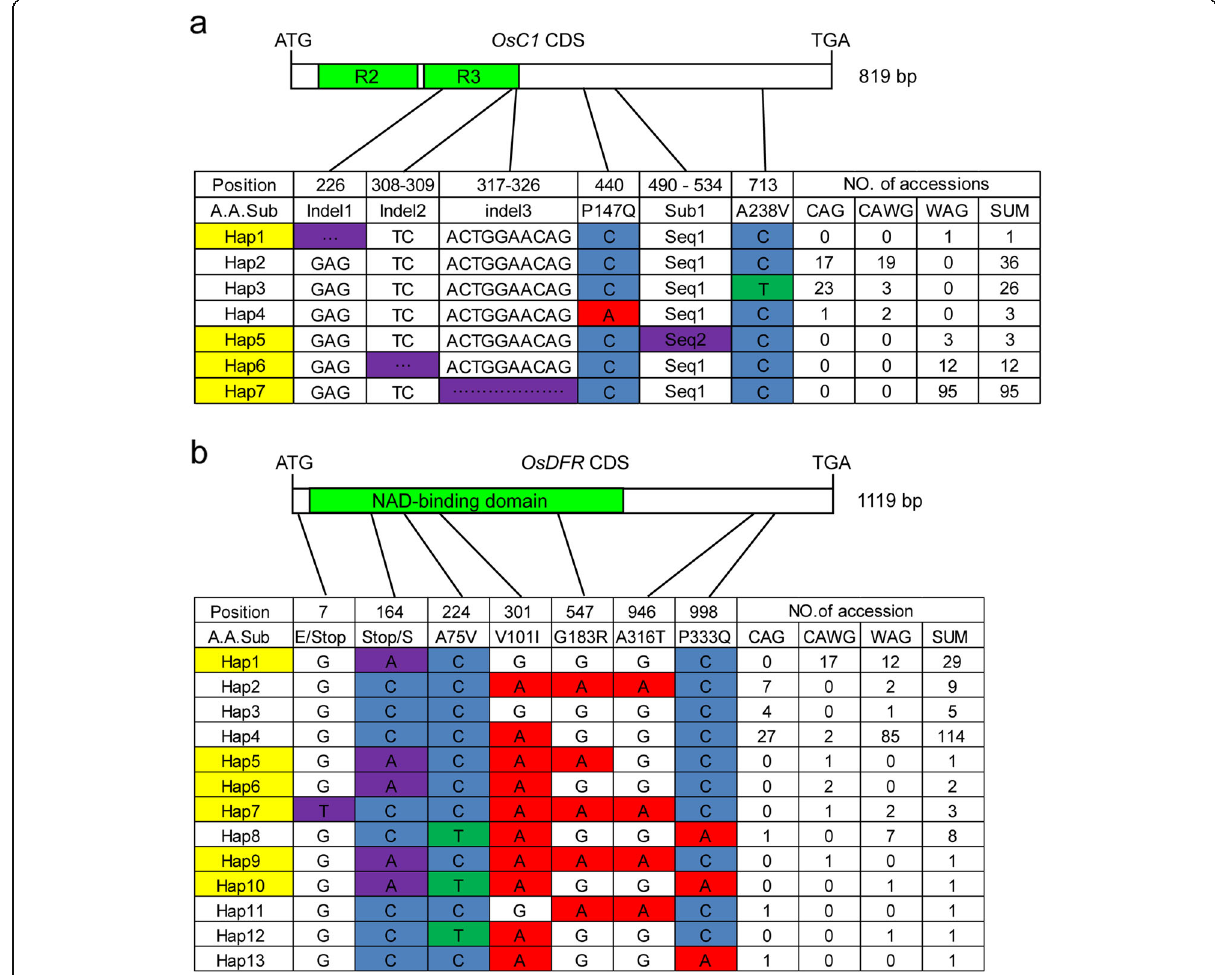
Fig. 8 Haplotype analysis of OsC1 and OsDFR in a panel of 176 rice accessions. Haplotype analysis of OsC1 ( a ) and OsDFR ( b ) in the mini core collection. A.A.Sub, indicates amino acid substitution. CAG, colored apiculi and colored stigmas; CAWG, colored apiculi and straw-white stigma; WAG, straw-white apiculi and straw-white stigma. Deletion and insertion sites are indicated by dashed lines. Haplotype analyses of OsC1 and OsDFR were conducted according to the sequences of Nipponbare (Hap1). Non-functional haplotype is in yellow. Polymorphic nucleotides causing loss-of-function are in purple. The number of accessions of each haplotype is shown in the right column. Sub1, substitution of ACGGCA GCGGCGGCGGCGGCGGCGACGACGA CCACCGTGTGGGCG (Seq1) by GCAGCCAGCCT